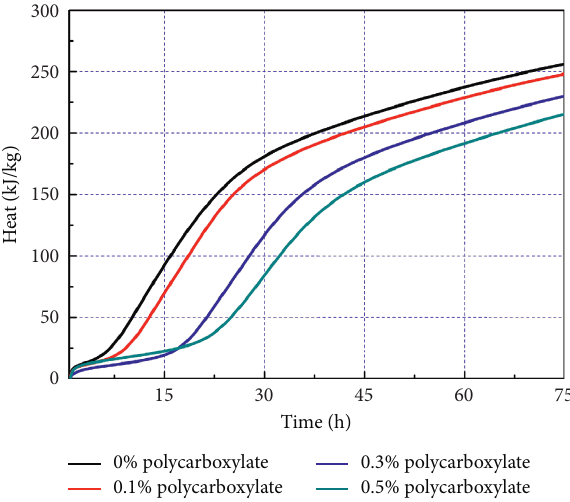
Figure 6: Effect of PCE-2 dosage on hydration heat of cement pastes with 10%